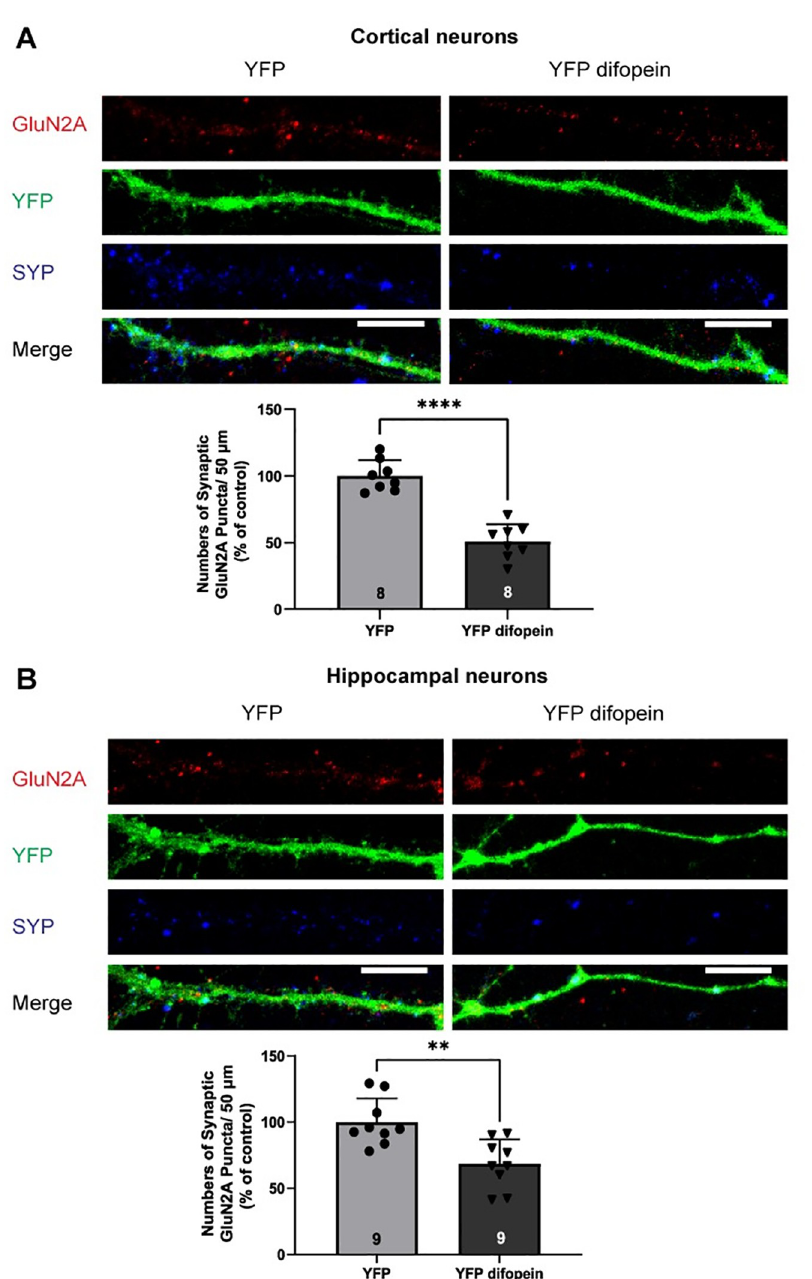
Fig 2. Inhibition of 14-3-3 proteins leads to reduced numbers of synaptic GluN2A puncta in primary glutamatergic cortical and hippocampal neurons. A , Representative images of YFP-difopein or YFP infected cortical neurons labeled with GluN2A (red), YFP (green), and SYP (blue) at DIV21. Bars , Illustrate numbers of synaptic GluN2A puncta/50 μ m in YFP-difopein treated glutamatergic cortical neurons normalized to YFP controls (two-tailed unpaired Student’s t -test: ���� p < 0.0001, n = 8). B , Representative images of YFP-difopein or YFP infected hippocampal neurons labeled with GluN2A (red), YFP (green), and SYP (blue) at DIV21. Bars , Illustrate numbers of synaptic GluN2A puncta/50 μ m in YFP-difopein treated glutamatergic hippocampal neurons normalized to YFP controls (two-tailed unpaired Student’s t -test: �� p = 0.0020, n = 9). Error bars indicate SD. Scale bar, 10 μ m.